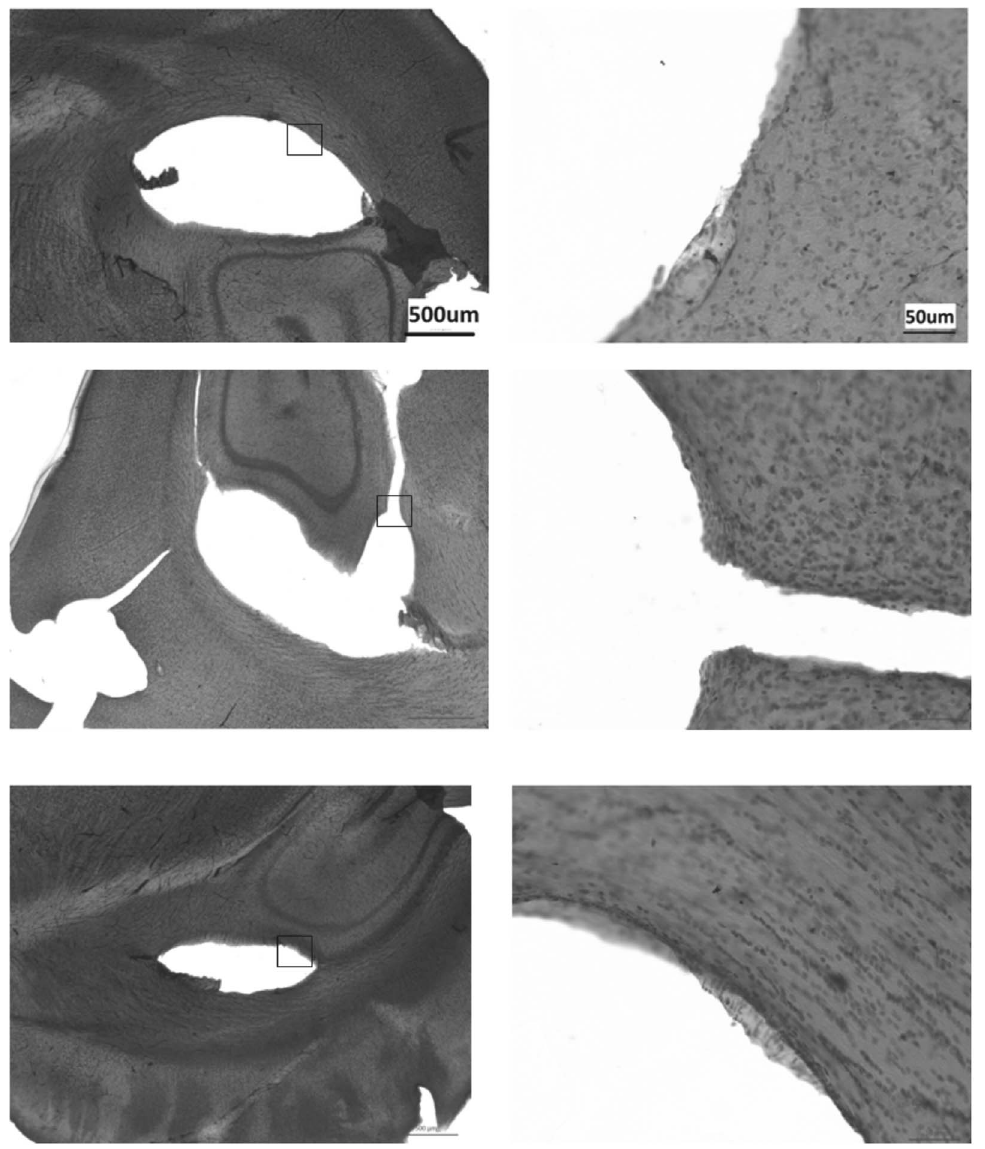
Figure 3. Representative histological sections at respective arteries of sham SHR. Top panel: ICA, middle panel: MCA and bottom panel: ACA. Left pictures were taken at 10x magnification. Squares in the left panel indicate ROI magnified on the right magnified at 40x. All images follow the same scale bar of the image in their corresponding top panel.